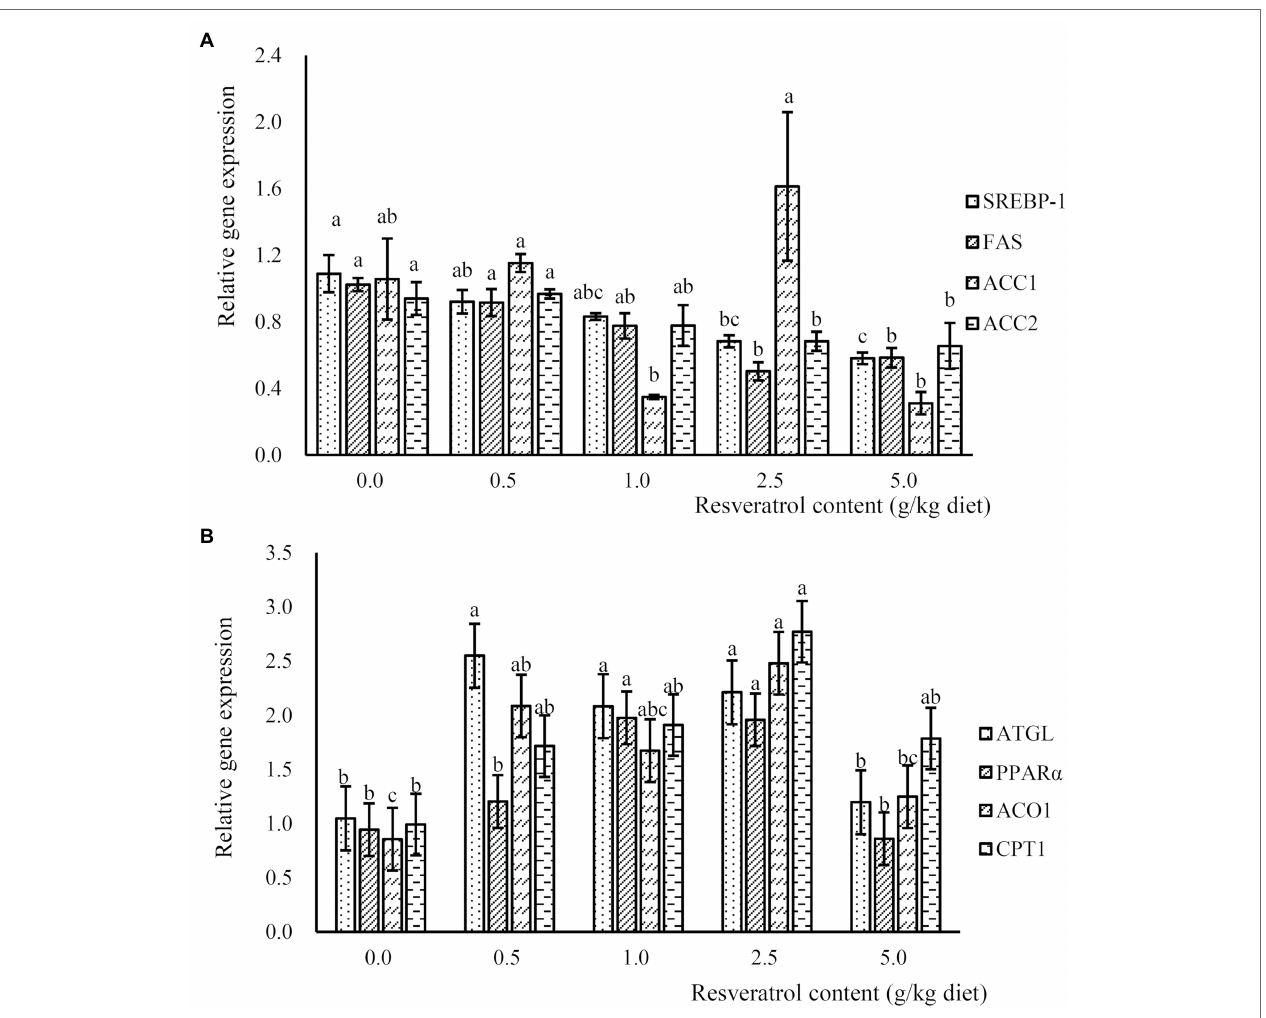
FIGURE 5 | The expression of lipogenesis relates genes, SREBP-1, FAS, ACC1 and ACC2 (A) , and lipolysis related genes, ATGL, PPAR α , ACO1 and CPT1 (B) , in response to graded levels of dietary RSV in largemouth bass for 10 weeks. Values (means ± standard error of the mean, SEM) in bars that have the same letter are not significantly different ( p > 0.05; Duncan’s test) among treatments ( N =